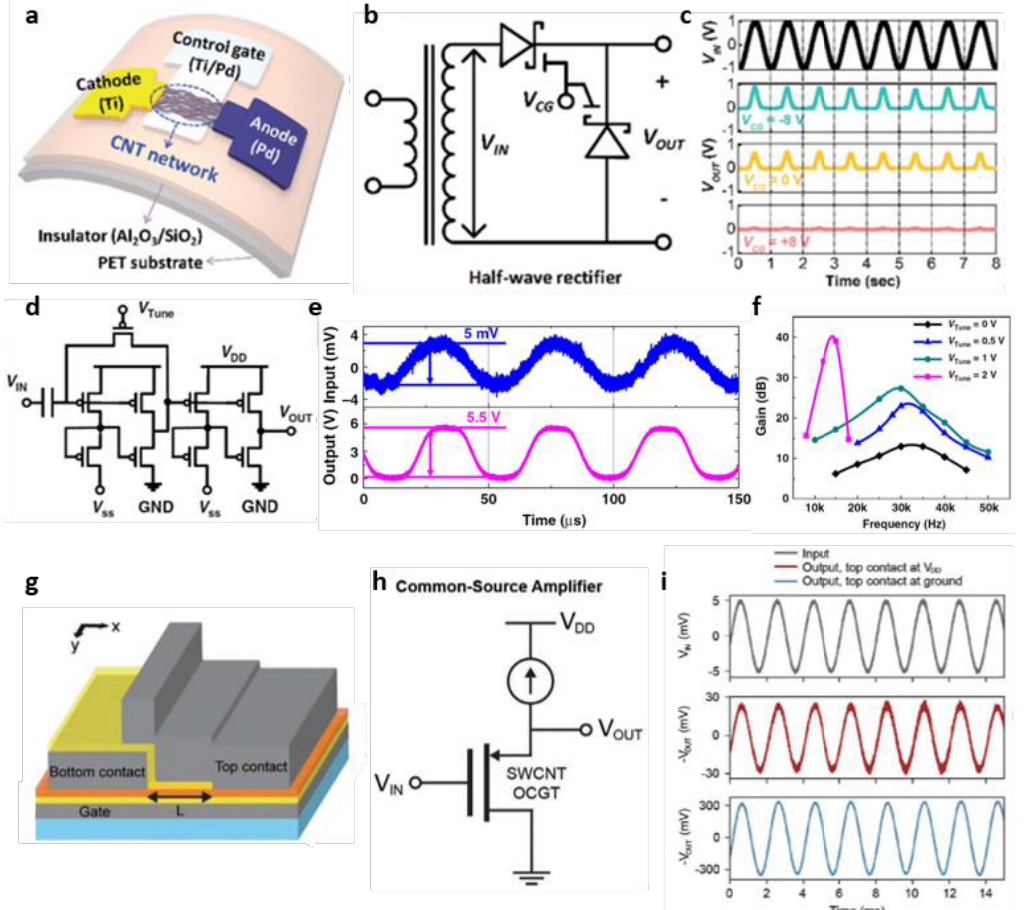
Figure 6. CNT-based thin-film analog circuits. ( a ) Structural illustration of the flexible CNT Schottky diode with a control gate. ( b ) Schematic diagram of a half-wavelength rectifier circuit composed of two CNT Schottky diodes and ( c ) rectification characteristics dependent on the control gate voltage (adapted from [75] with permission from RSC Publishing). ( d ) Circuit diagram of CNT-based amplifier with post-fabrication tunability through voltage of V Tune node. ( e ) Output characteristics when an input signal with a peak-to-peak voltage of 5 mV is applied to the amplifier. ( f ) When V Tune is adjusted within 0 V to 2 V, the corresponding gain and bandwidth (adapted from [76] with permission from Springer Nature). ( g ) Structural schematic diagram of CNT-based ohmic-contact-gated transistor. ( h ) Circuit diagram of a common source amplifier using a CNT-based ohmic-contact-gated transistor and ( i ) its input/output characteristics according to the position of the voltage-applying electrode (adapted from [77] with permission from John Wiley and Sons).